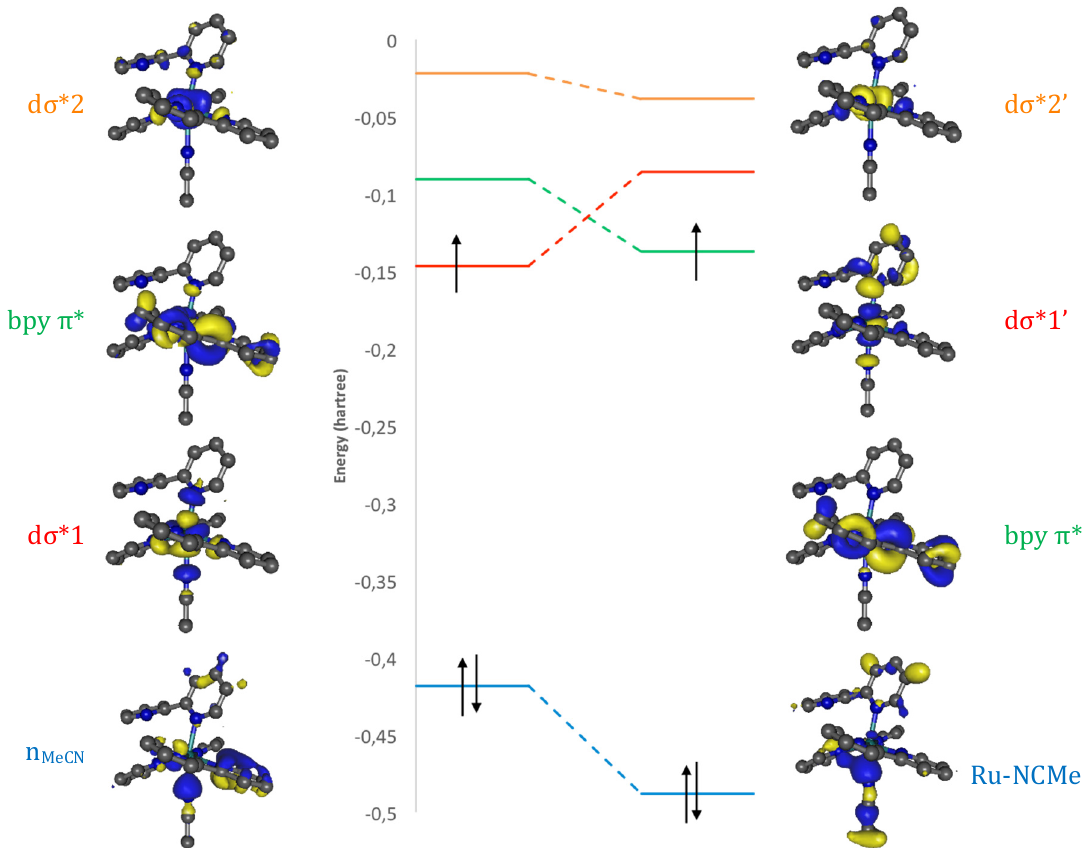
Figure 6. Partial MO correlation diagram between beads 17.50 and 17.75 (Kohn–Sham orbitals), showing NCMe coordination at bead 17.75 (a more complete MO diagram is given as Figure S2).